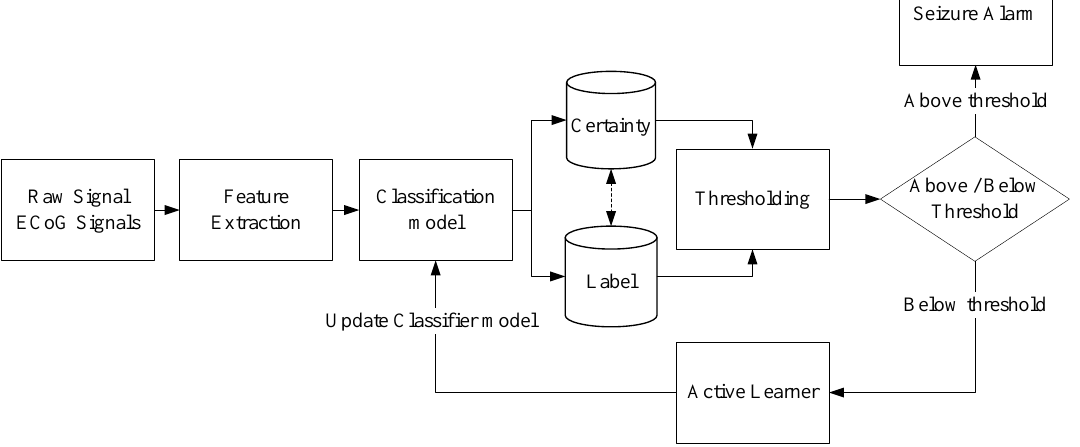
Figure 3. Schematic flow of our seizure prediction framework. The base classifier is expected to output both soft label (or degree of certainty), which is used to determine the certainty of the classification and crisp label (or label) to know the